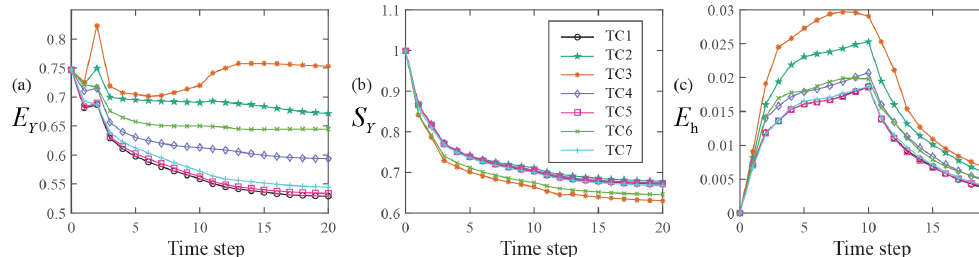
Figure 6. Temporal evolution of E Y (a) , S Y (b) , and E h (c) for TC1–TC7.